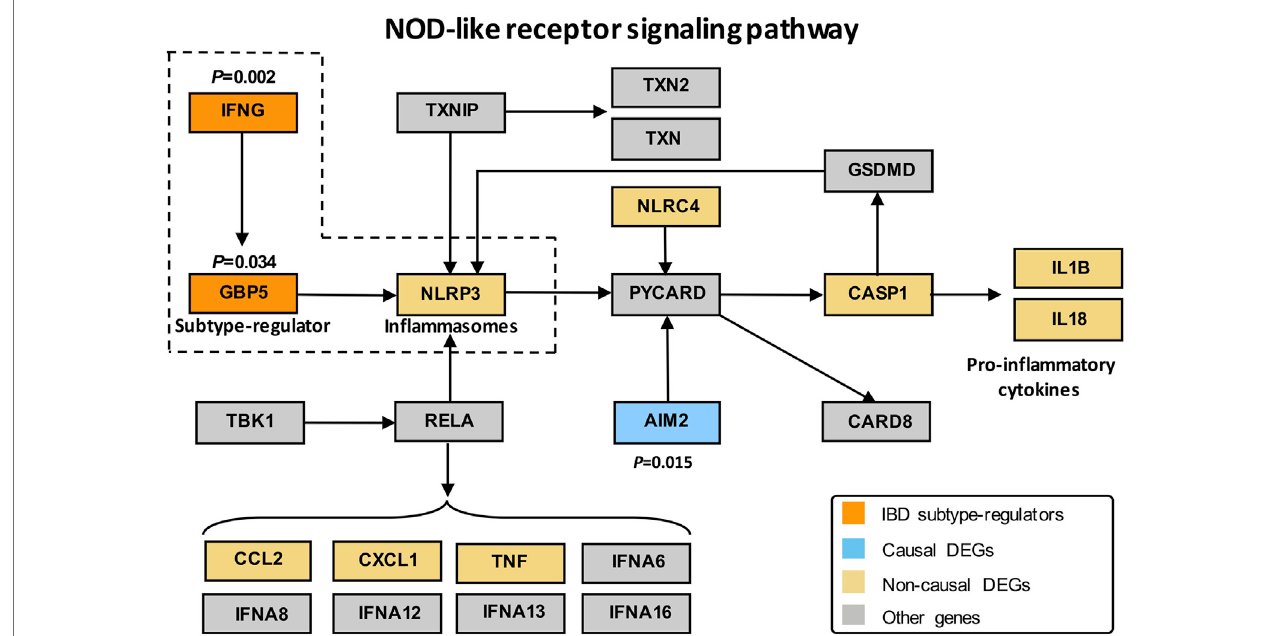
FIGURE 5 | Subnetwork of the DEPs KEGG network with IFNG , GBP5 , and NLRP3 . Orange, blue, yellow, and gray represent subtype-regulators, causal DEGs, non-causal DEGs, and other genes, respectively, in DEPs. DEGs refer to differentially expressed genes between IBD and control groups. Subtype-regulators are DEGs with p < 0.05 in the causal effect signi fi cance test (see Method for detail) and showed statistical differences between CD and UC; causal DEGs represent DEGs with p < 0.05 in the causal effect signi fi cance test; non-causal DEGs represent DEGs with p > 0.05 in the causal effect signi fi cance test.